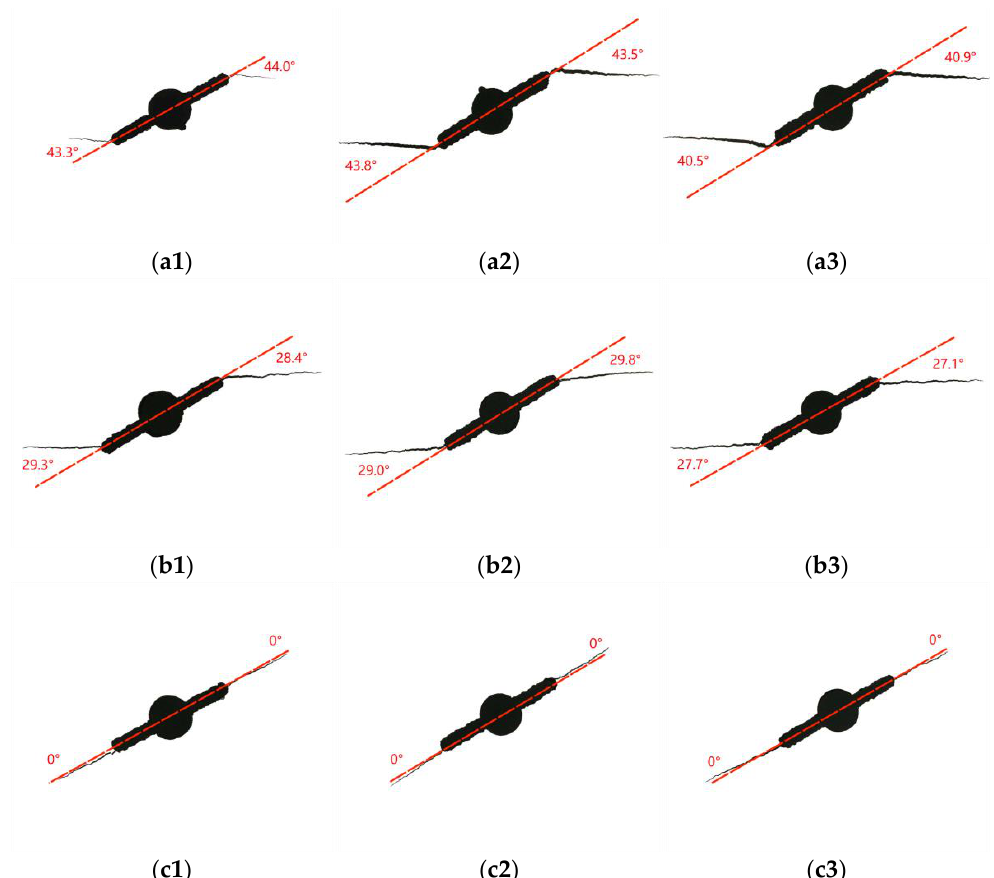
Figure 3. Propagation path under crack inclination angle 60°. ( a1 ) β = 60°, λ = 0, R = 0. ( a2 ) β = 60°, λ = 0, R = 0.1. ( a3 ) β = 60°, λ = 0, R = 0.3. ( b1 ) β = 60°, λ = 0.5, R = 0. ( b2 ) β = 60°, λ = 0.5, R = 0.1. ( b3 ) β = 60°, λ = 0.5, R = 0.3. ( c1 ) β = 60°, λ = 1, R = 0. ( c2 ) β = 60°, λ = 1, R = 0.1. ( c3 ) β = 60°, λ = 1, R = 0.3.